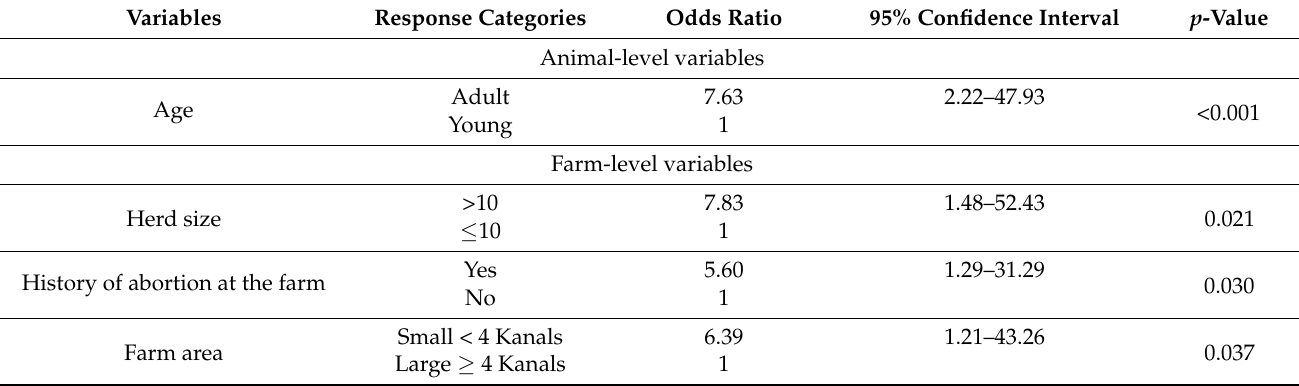
Table 4. Summary of the animal-level and farm-level risk factors associated with the occurrence of brucellosis in the final